Question: Write a single sentence explaining what this figure depicts.
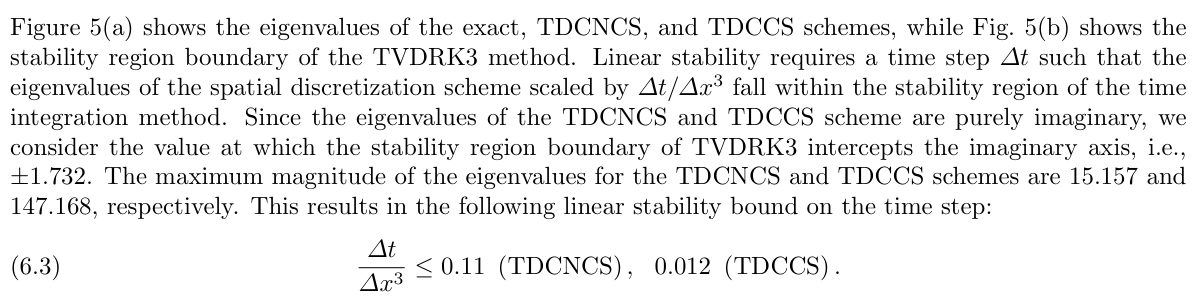
Answer: (a) shows the eigenvalues of the exact, TDCNCS, and TDCCS schemes, while Fig. 5(b) shows the stability region boundary of the TVDRK3 method. Linear stability requires a time step ∆t such that the eigenvalues of the spatial discretization scheme scaled by ∆t/∆x3 fall within the stability region of the time integration method. Since the eigenvalues of the TDCNCS and TDCCS scheme are purely imaginary, we consider the value at which the stability region boundary of TVDRK3 intercepts the imaginary axis, i.e., ±1.732. The maximum magnitude of the eigenvalues for the TDCNCS and TDCCS schemes are 15.157 and 147.168, respectively. This results in the following linear stability bound on the time step: